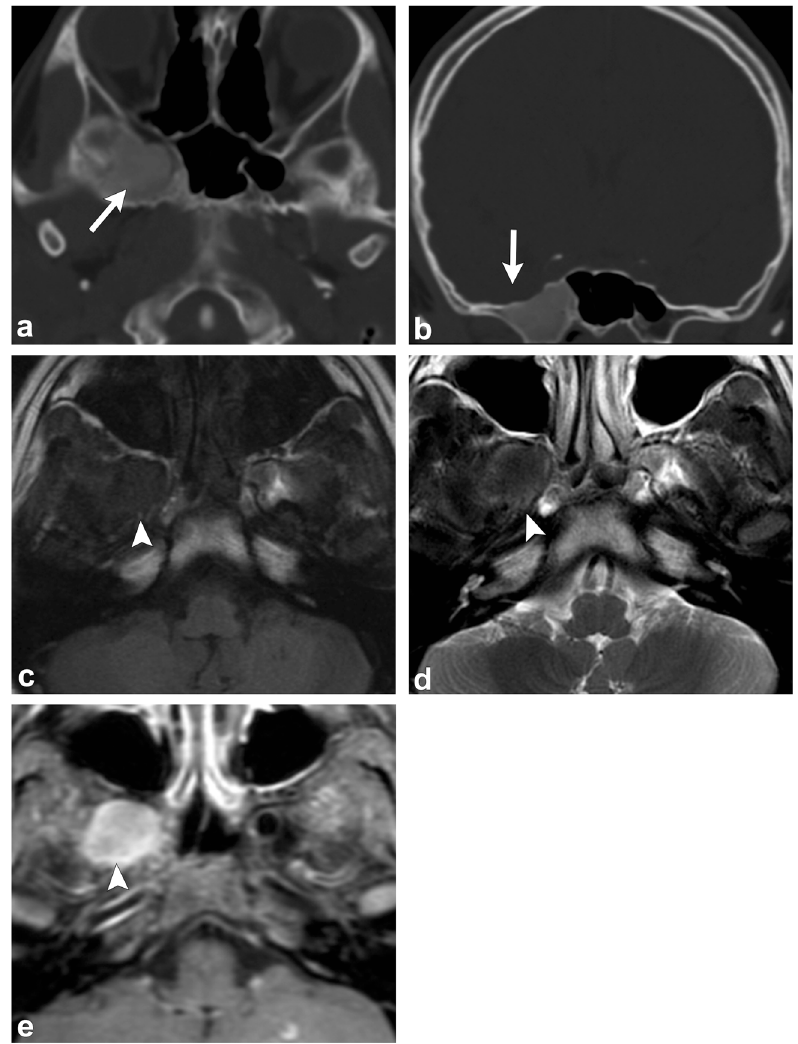
Fig. 2 Fibrous dysplasia.